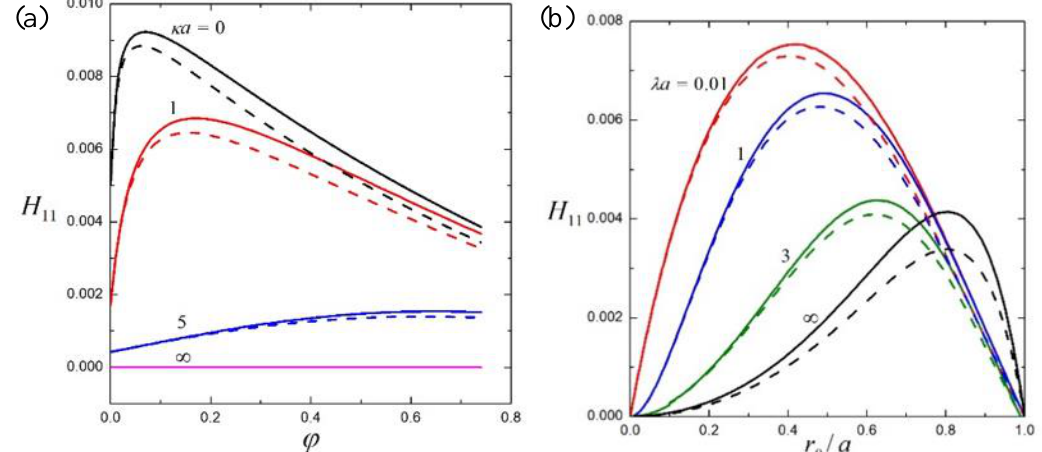
Figure 7. The chemiphoretic mobility coe ffi cient H 02 for a suspension of soft spheres: ( a ) λ a = 1 and r 0 / a = 0.5; ( b ) κ a = 1 and ϕ = 0.1. The solid and dashed curves represent the calculations for the Happel and Kuwabara models, respectively.